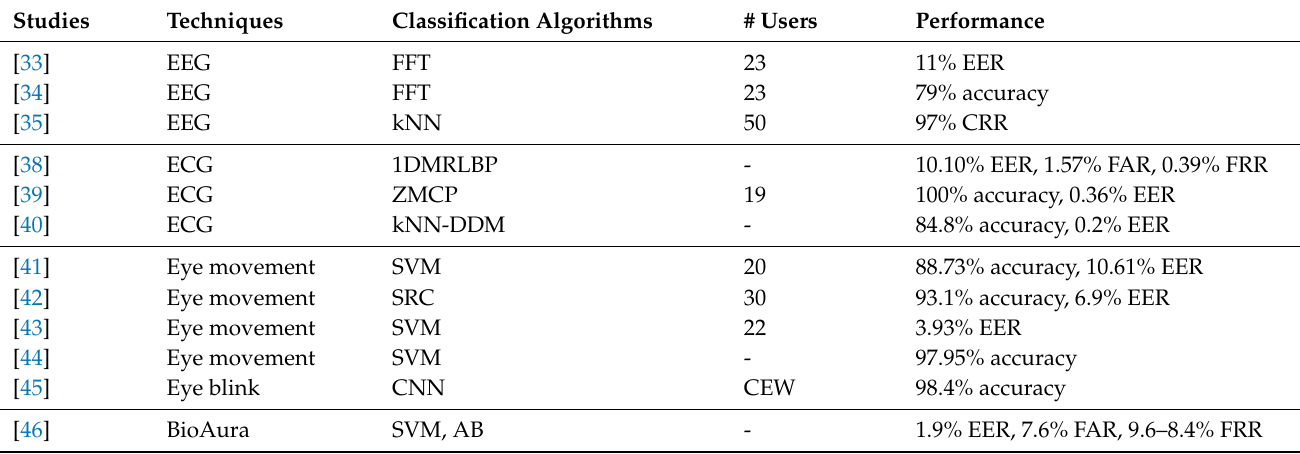
Table 2. EEG-, ECG-, and eye-movement-based authentication.